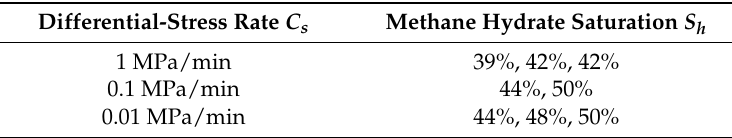
Table 2. Conditions of constant-stress-rate tests.